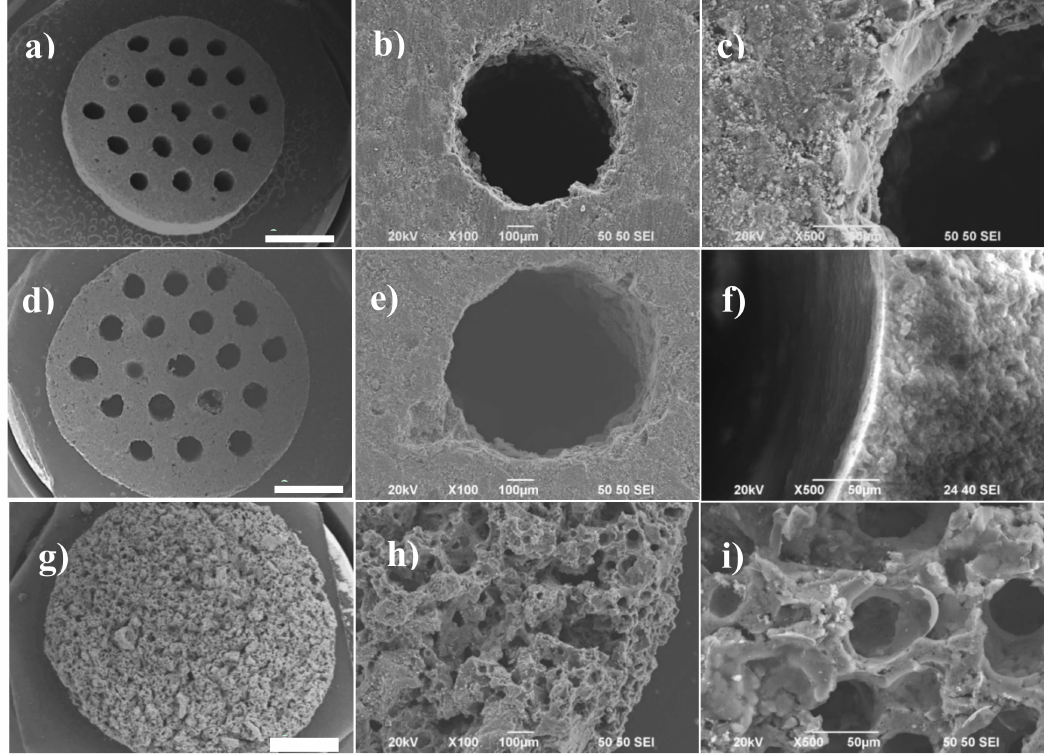
Figure 1. SEM micrographs of the activated carbon monoliths (ACMs) obtained from olive stone ( a – c ); Alcell lignin ( d – f ); and Kraft lignin ( g – i ), at an impregnation ratio of 1. Bar length of ( a ), ( d ), and ( g ) 2